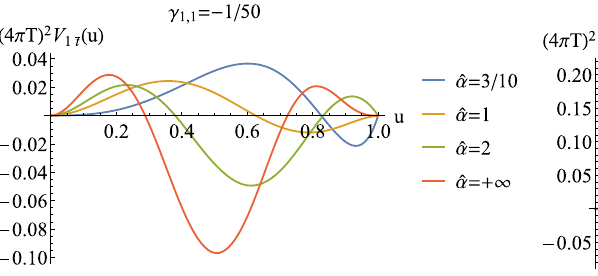
Fig. 25 The potentials ( 4 π T ) 2 V 1 ¯ t ( u ) with representative γ 1 , 1 and ˆ α